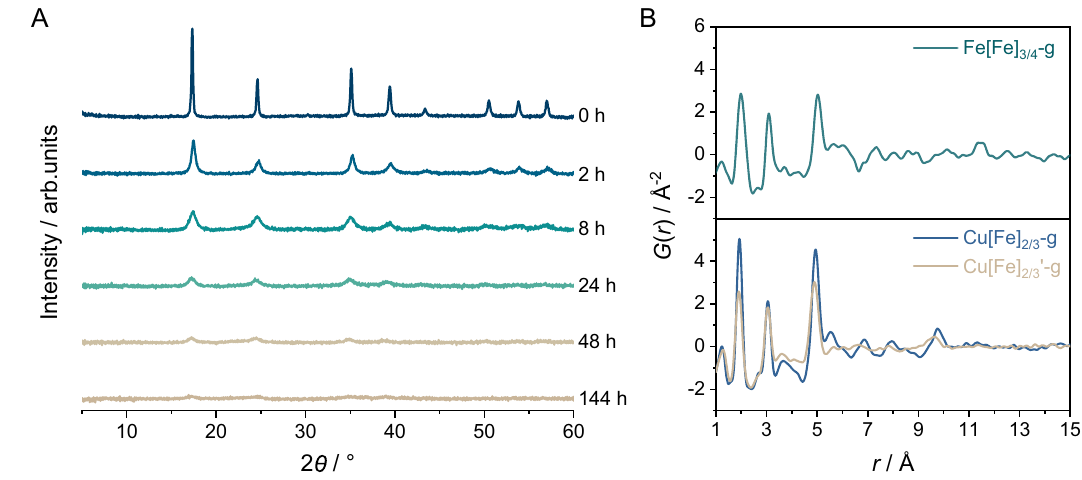
Fig. 4 Effect of vacancies fraction and hydration. A PXRD of Fe[Fe] 3/4 after mechanical milling for 0, 2, 8, 24, 48, and 144 h ( λ = 1.5406 Å). B PDFs of Fe[Fe] 3/4 -g (144 h milling), Cu[Fe] 2/3 -g (2 h milling), and Cu[Fe] 2/3 '-g (2 h milling). Source data are provided as a Source Data fi